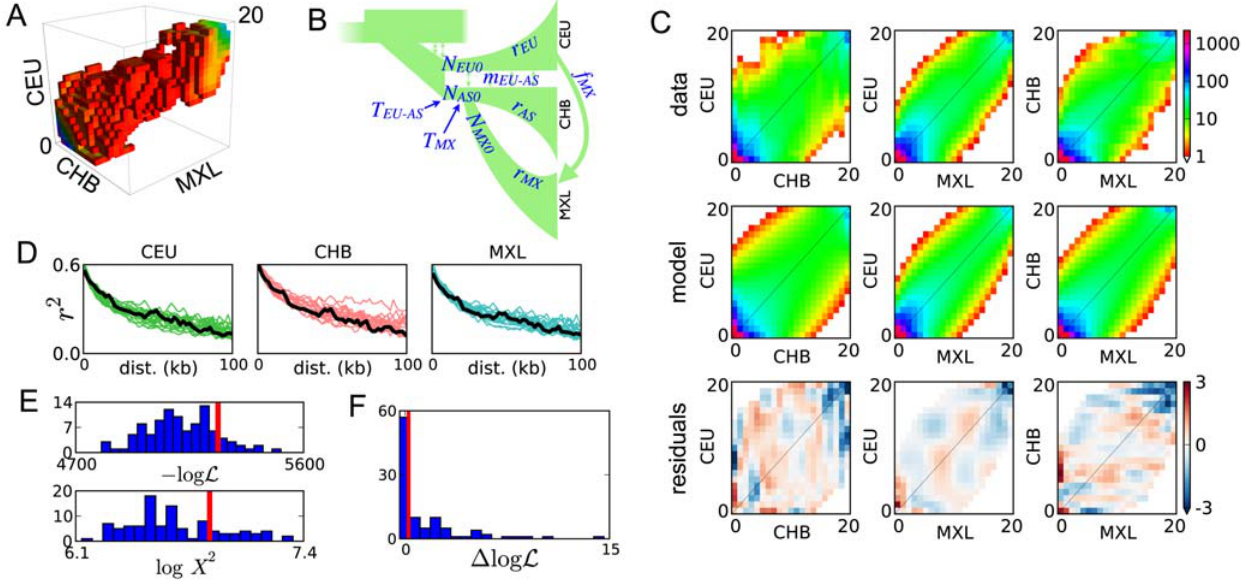
Figure 3. Settlement of the New World analysis. As in Figure 2, (A) is the data, (B) is a schematic of the model we fit, (C) compares the data and model AFS, and (D) compares LD. (E) The fit of our model to the real data is not atypical of fits to simulated data. (F) The improvement in real data fit upon including CHB-MXL migration (red line) is very typical of the improvement in fits to simulated data without CHB-MXL migration. Thus we have no evidence for CHB-MXL migration after divergence.